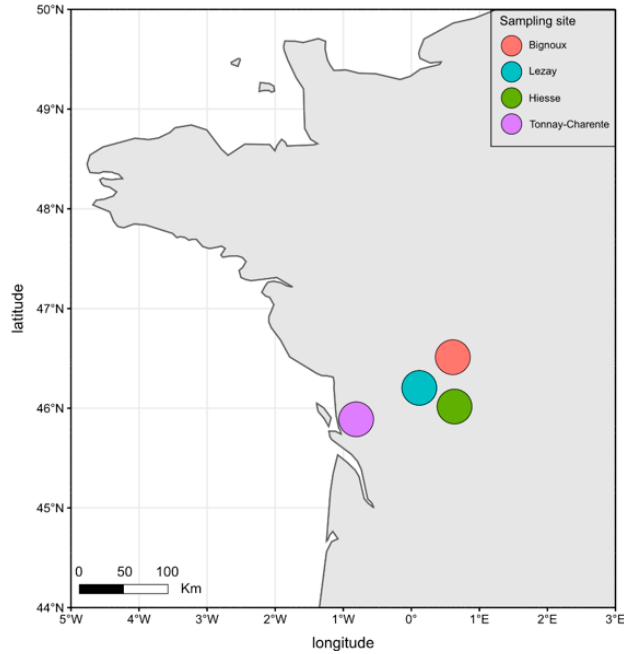
Figure 1. The sampling areas in Western France. Table 1. Diversity index calculated for each sampling site. Calculations were carried out after probable contaminant reads removal. An uneven number of individuals is due to samples exclusion based on the Bray-Curtis dissimilarity index